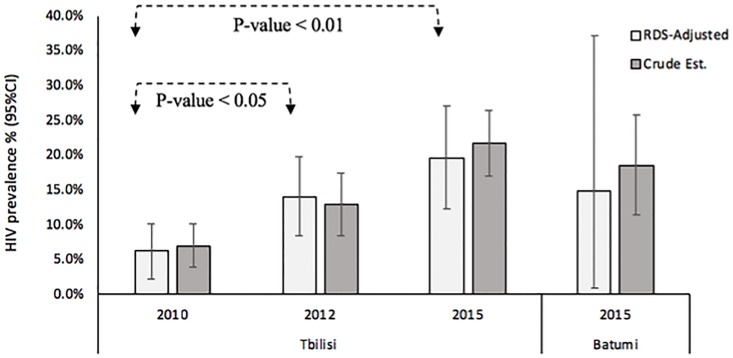
Trend in HIV prevalence among men who have sex with men in Georgia, 2010 to 2015.Gile’s SS method was used to calculate the RDS-adjusted estimates. Crude estimates were calculated assuming simple random sampling as the recruitment strategy.